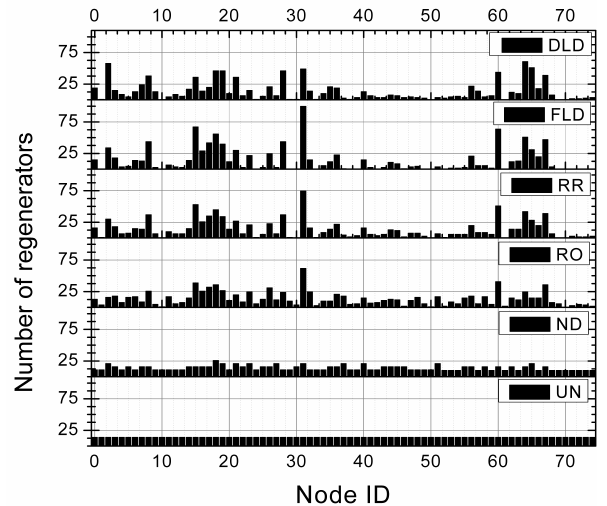
Figure 4. Number of regenerators placed by each considered RP algorithm in each network node of CoreNet assuming the uniform traffic and total amount of 1050 regenerators placed in the